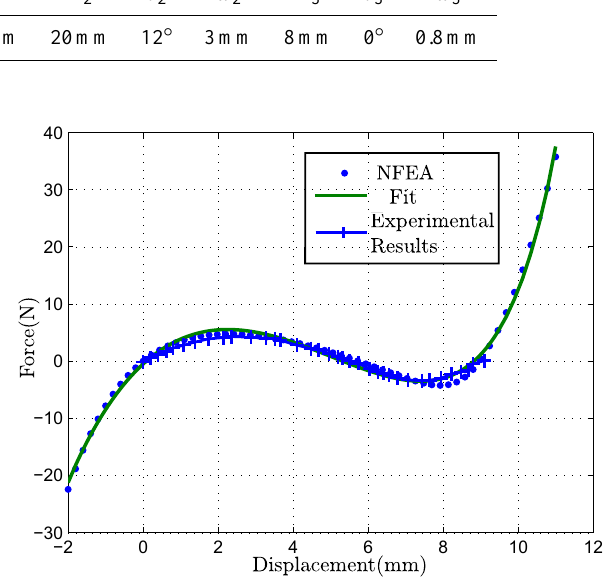
Figure 5. The complete bistable kinetostatic behaviors of the clas- sic fully-compliant bistable mechanism.